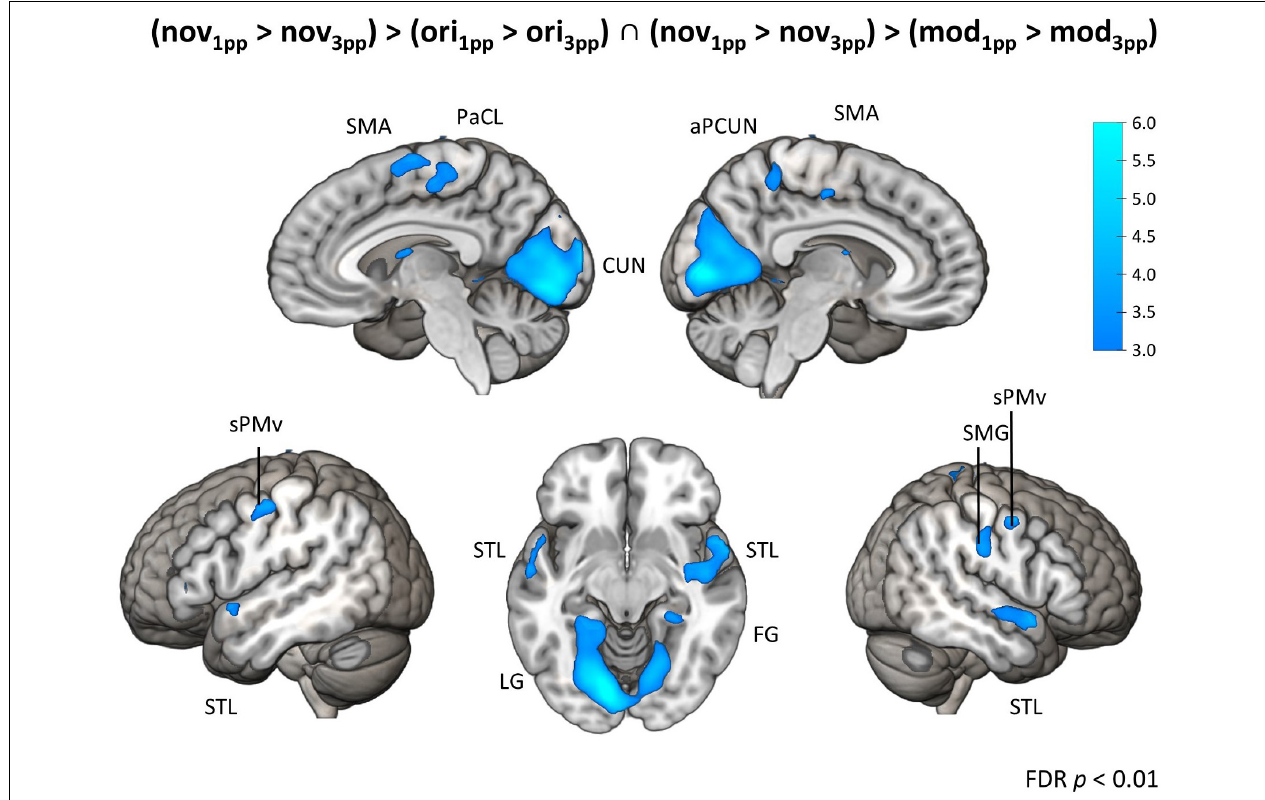
FIGURE 9 | Brain activation for perspective. Conjunction contrast showing enhanced brain activity for interaction contrasts of novels vs. original and novels vs. modified versions (nov 1pp > nov 3pp ) > (ori 1pp > ori 3pp ) ∩ (nov 1pp > nov 3pp ) > (mod 1pp > mod 3pp ). Activity patterns indicate enhanced activity for a first-person perspective (1pp) compared to a third-person perspective (3pp) for t -map at p < 0.01 (FDR-corrected). SMA, supplementary motor area; PaCL, paracentral